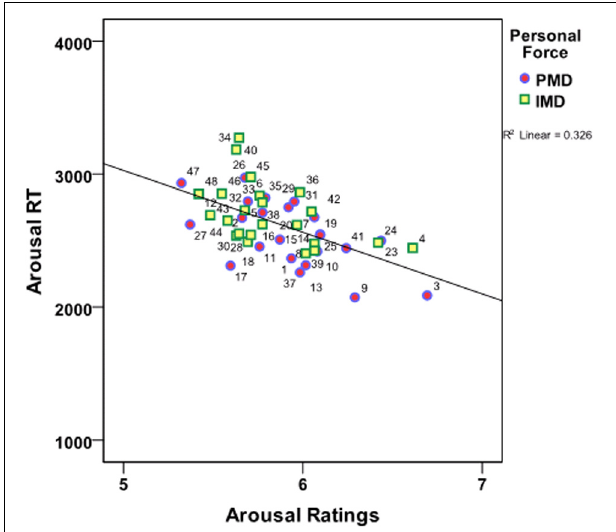
FIGURE 3 | Correlation between Arousal ratings and the RT. Color coding: Personal Moral Dilemmas (PMD; Blue/Red, circles); Impersonal Moral Dilemmas (IMD; Green/Yellow, squares). Arousal ratings are 1 = Not arousing, calm; 7 = Very arousing, on the x-axis. RT is in milliseconds (ms) on the y-axis. The numbers refer to the dilemma numbers in the dilemma